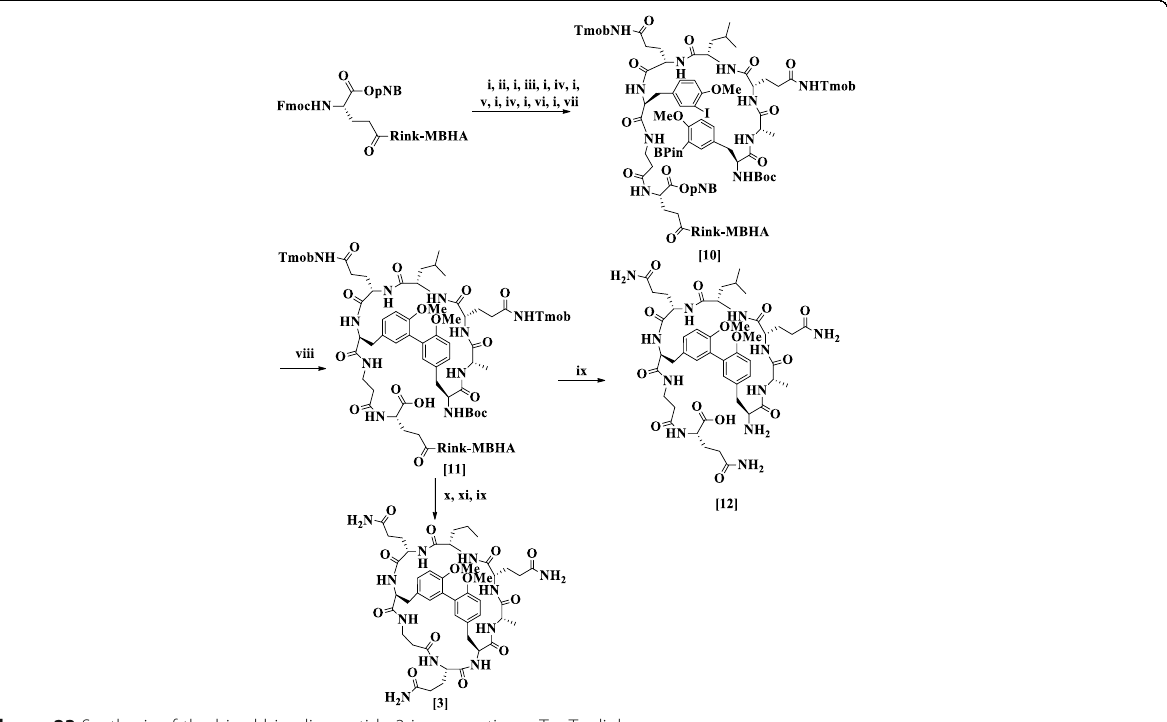
Scheme 23 Synthesis of the biaryl bicyclic peptide 3 incorporating a Tyr-Tyr